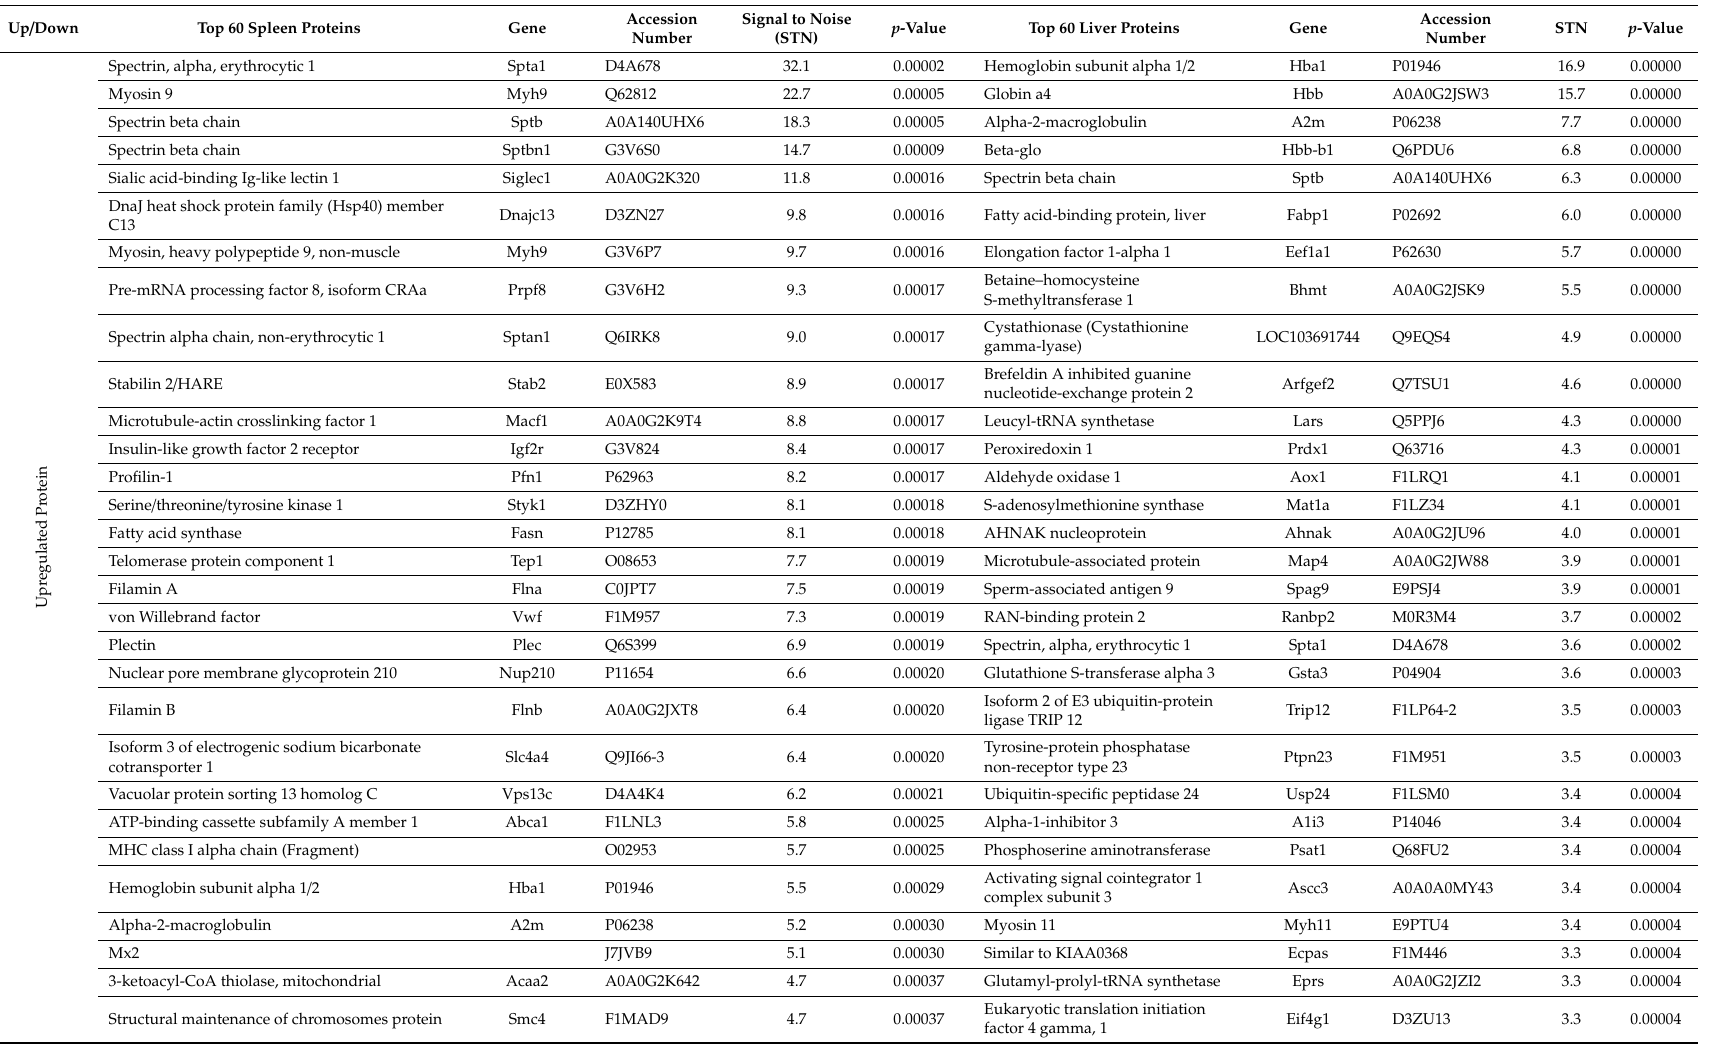
Table 3. Selected biosignature candidate proteins identified in the spleen and liver of the aged rat treated with NFP. Up /